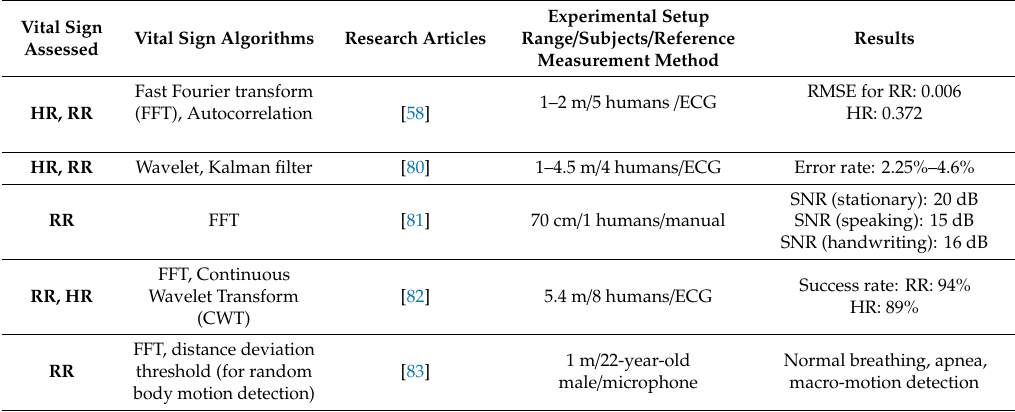
Table 3. Performance comparison of vital sign detection algorithms for non-stationary